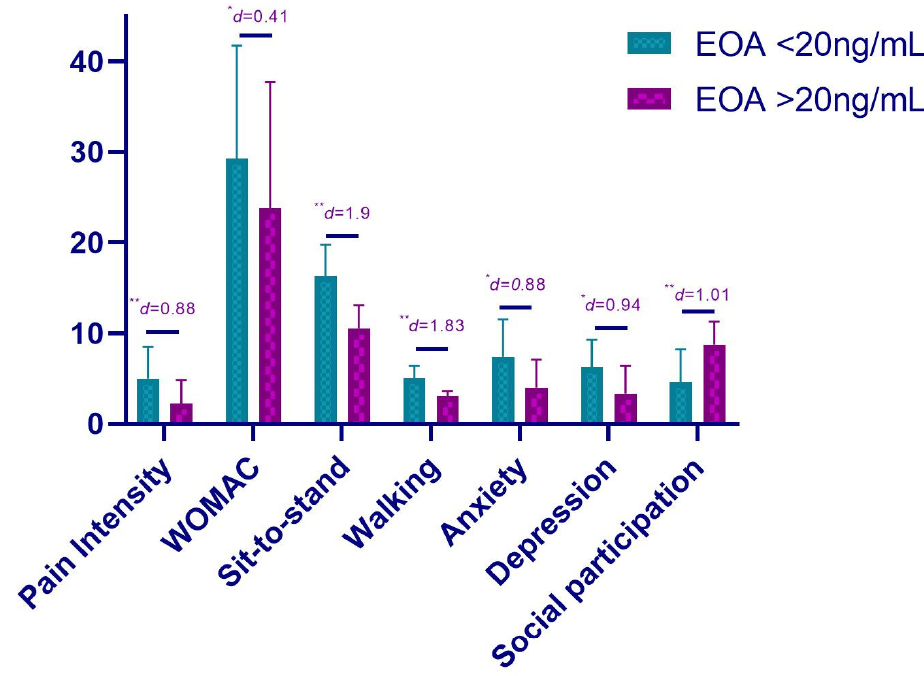
Figure 2. Physical and psychological status according to vitamin D levels. ** p < 0.01; * p <